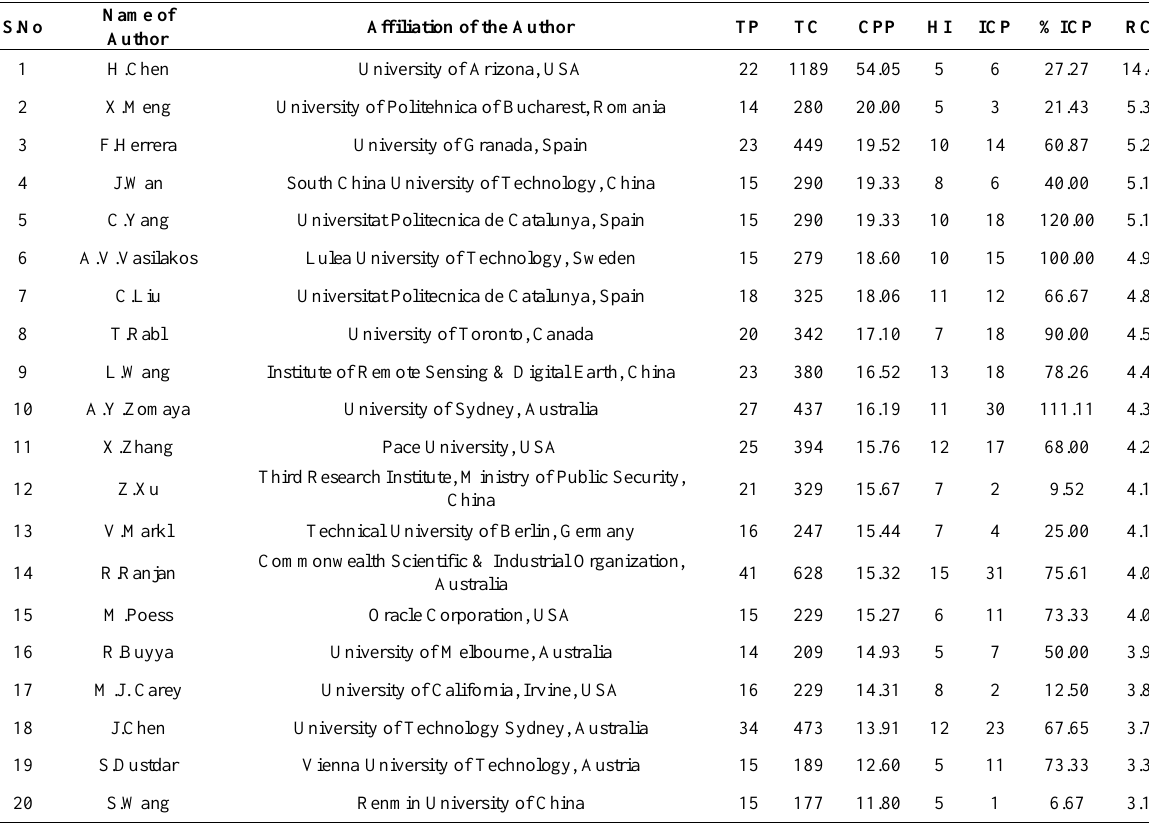
Table 10. Relative Citation Index of Top 20 Authors in Big Data Research, 2007-16.